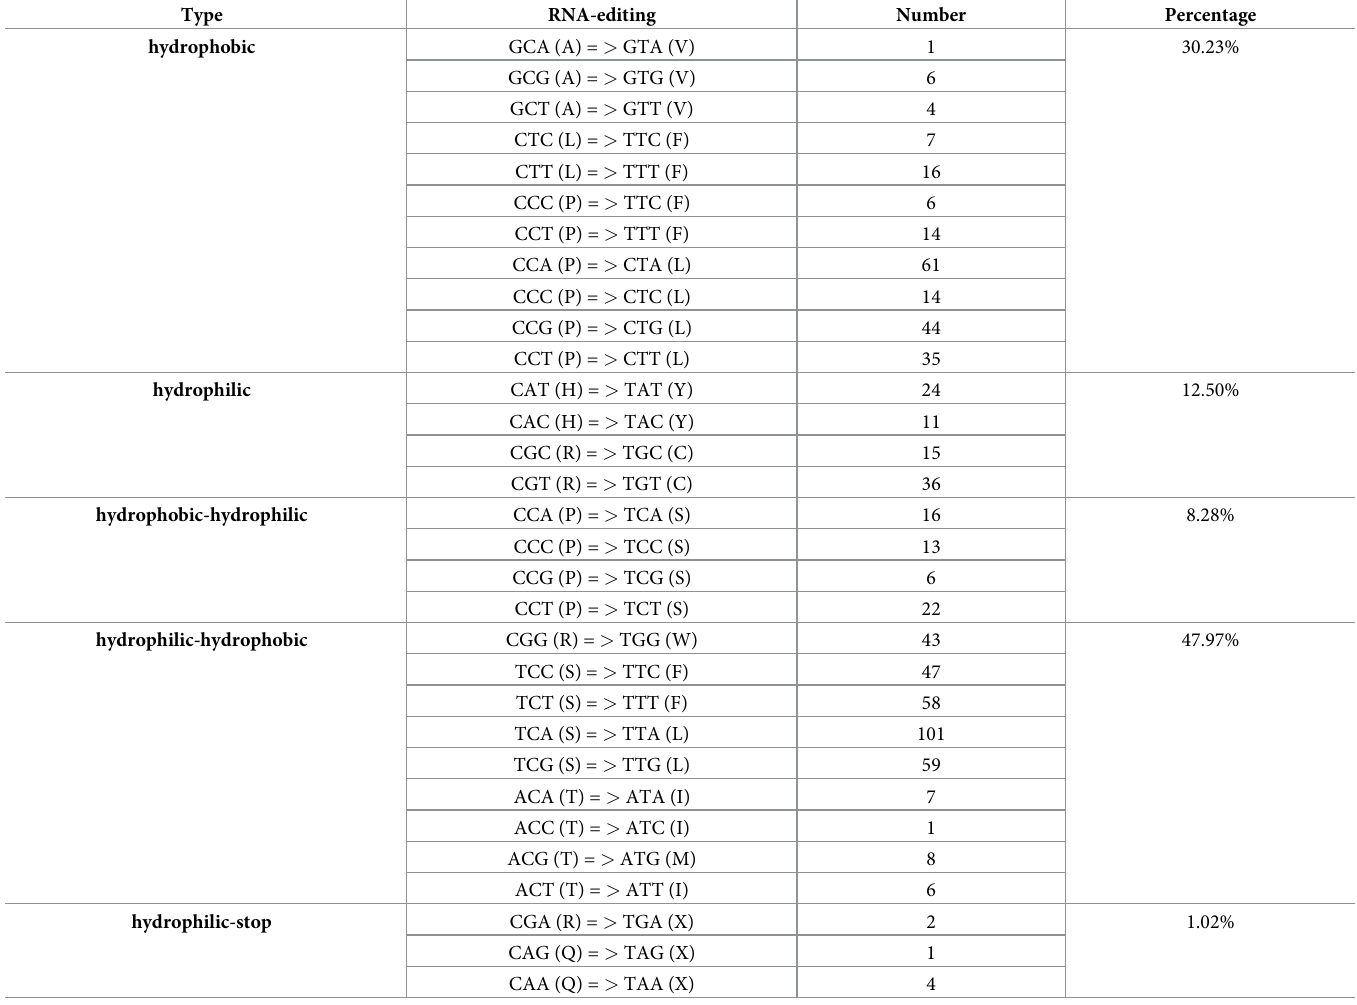
verted from hydrophobic to hydrophilic, and 47.9% (330 positions) from hydrophilic to hydrophobic. In addition, five amino acids were converted from glutamine to stop codons and two from arginine to stop codons (Table 2). The findings in this study revealed that most Table 2. Prediction of RNA editing